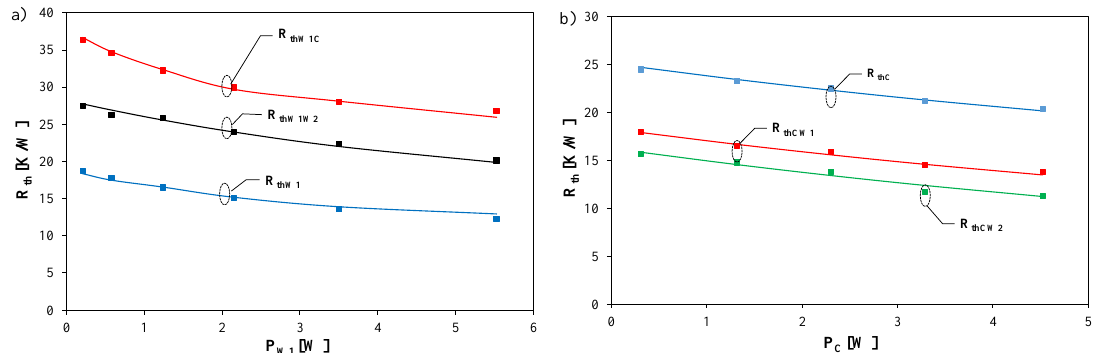
Figure 5. Measured (indicated by points) and modelled (indicated by lines) dependences of the selected thermal resistances in the thermal model of the transformer with a toroidal core made of powdered iron on the power dissipated in the primary winding.